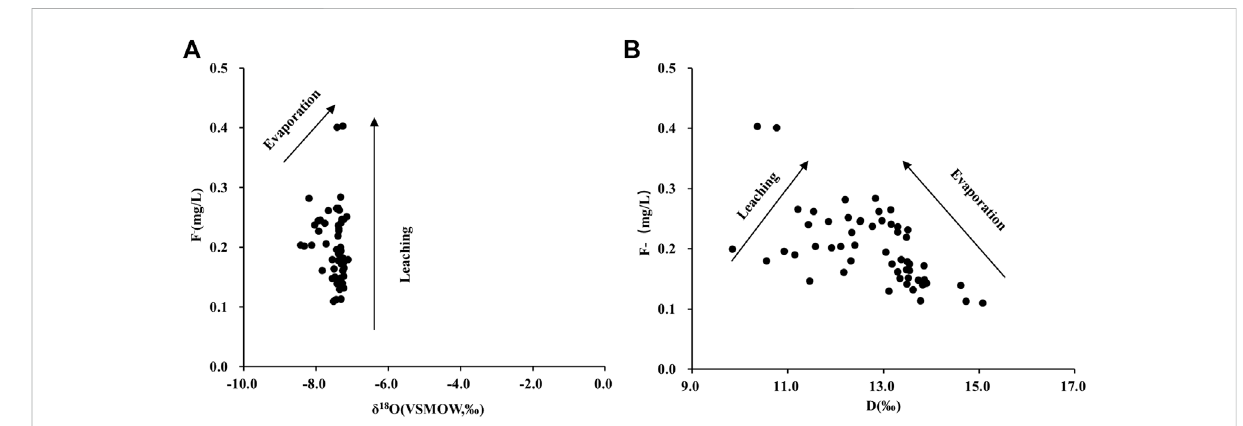
FIGURE 9 (A) Plot of F − concentration versus δ 18 O; (B) Plot of F − concentration versus